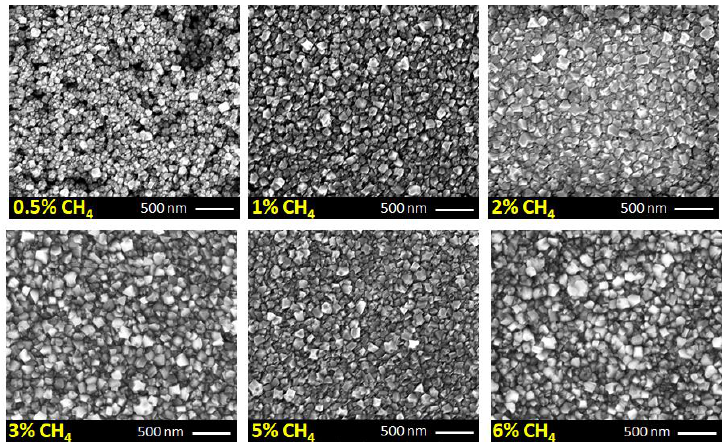
Figure 1. The effect of CH 4 content in the gas mixture on film uniformity and grain size (plan-view SEM micrographs).